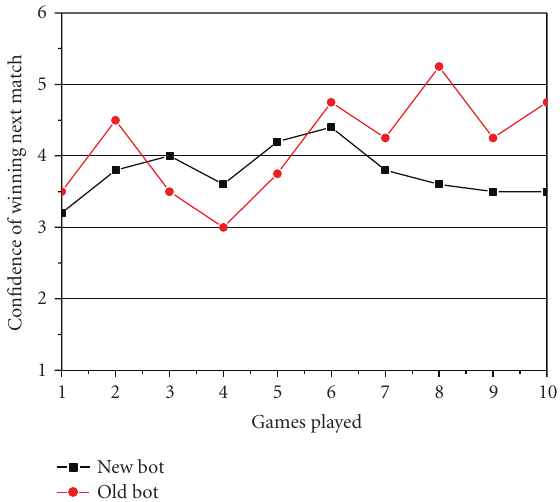
Figure 15: Comparison of survey results on the confidence of winning the next match (range from 1 = very low to 6 = very high) after each played game. Introversions bot is shown in red, while the new bot is shown in